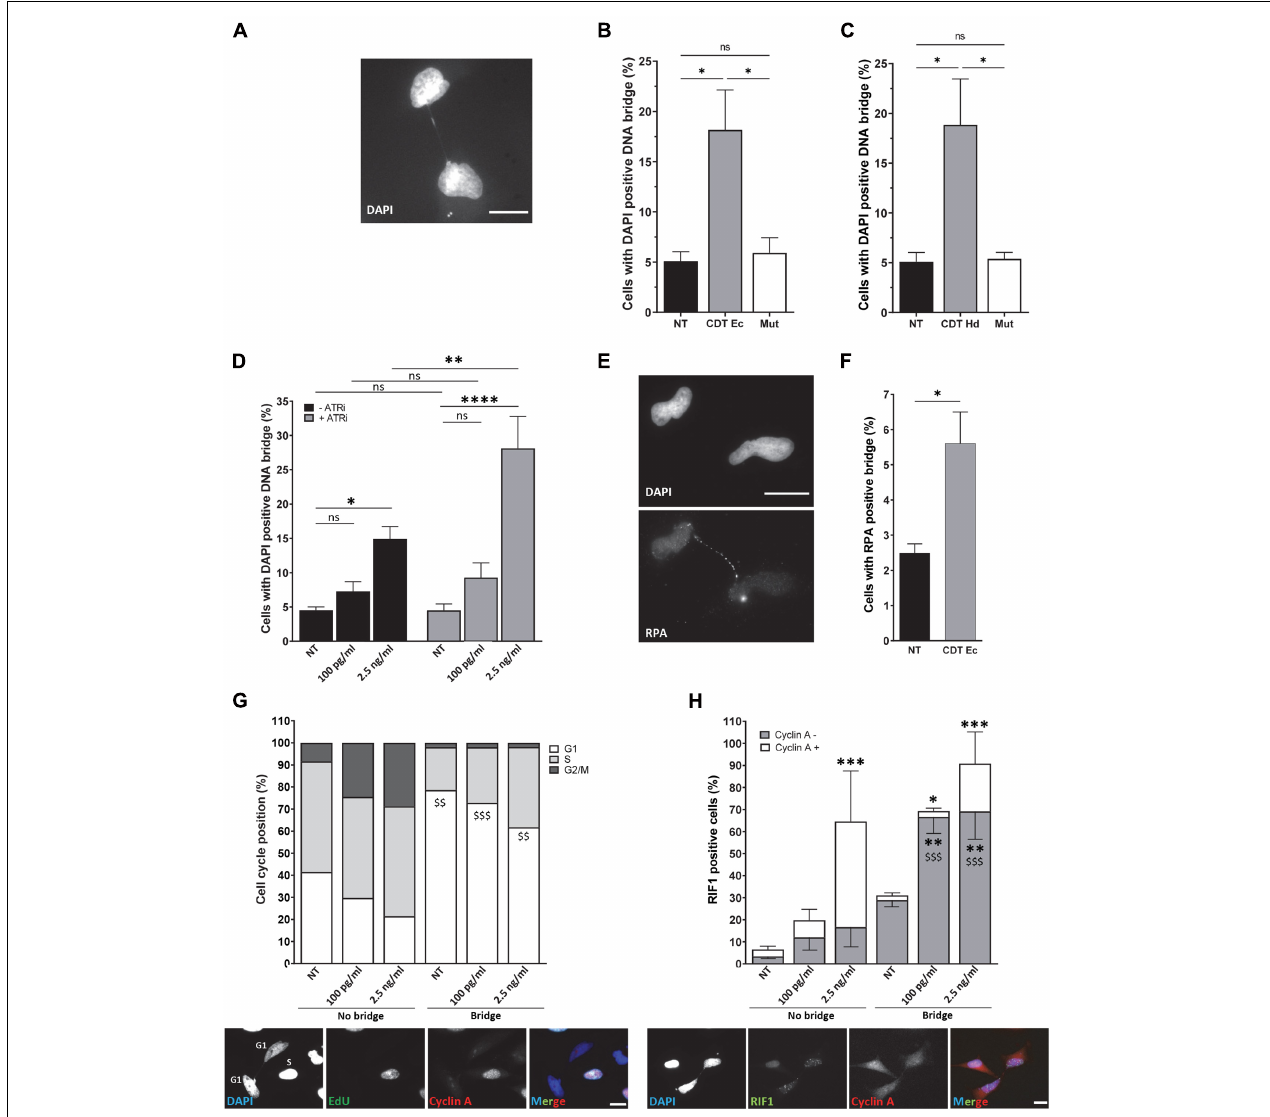
FIGURE 4 | ATR prevents the formation of persistent DNA bridges between G1 daughter cells. Illustration (A) and quantification (B) of HeLa cells with DAPI-positive DNA bridge (grayscale) after treatment or not (NT) with 2.5 ng/ml of wild-type (CDT Ec) or catalytically inactive CDT mutant (Mut) from E. coli for 24 h. N > 500 cells were analyzed with a wide-field fluorescent microscope. Scale bar: 20 µ m. (C) Quantification of HeLa cells with DAPI-positive DNA bridge after treatment or no treatment (NT) with 2.5 ng/ml of wild-type (CDT Hd) or catalytically inactive CDT mutant (Mut) from H. ducreyi for 24 h. N > 500 cells were analyzed with a wide-field fluorescent microscope (mean ± SEM of four independent experiments) ( ∗ P < 0.05, ns, not significant). (D) Quantification of HeLa cells with DAPI-positive DNA bridge after treatment or non-treatment (NT) with 100 pg/ml or 2.5 ng/ml of CDT from E. coli and ATR inhibitor (ATRi) for 24 h. N > 500 cells were analyzed with a wide-field fluorescent microscope (mean ± SEM of four independent experiments) ( ∗ P < 0.05, ∗∗ P < 0.01, ∗∗∗∗ P < 0.0001; ns, not significant). (E) Representative images of replication protein A (RPA) immunostaining (grayscale) and quantification (F) of HeLa cells with RPA-positive DNA bridge after treatment or no treatment (NT) with 2.5 ng/ml of CDT from E. coli (CDT Ec) for 24 h. Nuclei were stained with DAPI (grayscale) and n > 500 cells were analyzed with a wide-field fluorescent microscope. Scale bar: 20 µ m (mean ± SEM of four independent experiments) [ ∗ P < 0.05, versus non-treated (NT)]. (G) Upper panel: quantification of cell cycle position of HeLa cells linked or not with a bridge after E. coli CDT treatment [100 pg/ml or 2.5 ng/ml or non-treated (NT)] for 24 h (mean ± SEM of three independent experiments). Cyclin A and EdU-negative cells are counted in G1, cyclin A, and EdU-positive cells in S and cyclin A-positive and EdU-negative cells in G2. Lower panel: representative images of EdU (grayscale) and cyclin A (grayscale) immunostaining of HeLa cells treated with CDT from E. coli (2.5 ng/ml) for 24 h. Nuclei were stained with DAPI (grayscale). Merge was performed with DAPI (blue), EdU (green), and cyclin A (red) images. N > 100 cells were analyzed with a wide-field fluorescent microscope. Scale bar: 20 µ m ( $$ P < 0.01, $$$ P < 0.001 versus no bridge at the same CDT dose for the G1 phase). (H) Upper panel: quantification of positive HeLa cells for RIF1 ± cyclin A staining after E. coli CDT treatment [100 pg/ml or 2.5 ng/ml or non-treated (NT)] for 24 h (mean ± SEM of three independent experiments) [ ∗ P < 0.05, ∗∗ P < 0.01, ∗∗∗ P < 0.001 versus non-treated (NT) and $$$ P < 0.001 versus no bridge at the same CDT dose]. Lower panel: representative images of RIF1 (grayscale) and cyclin A (grayscale) immunostaining of HeLa cells treated with CDT from E. coli (2.5 ng/ml) for 24 h. Nuclei were stained with DAPI (grayscale). Merge was performed with DAPI (blue), RIF1 (green), and cyclin A (red) images. N > 100 cells were analyzed with a wide-field fluorescent microscope. Scale bar: 20 µ m.